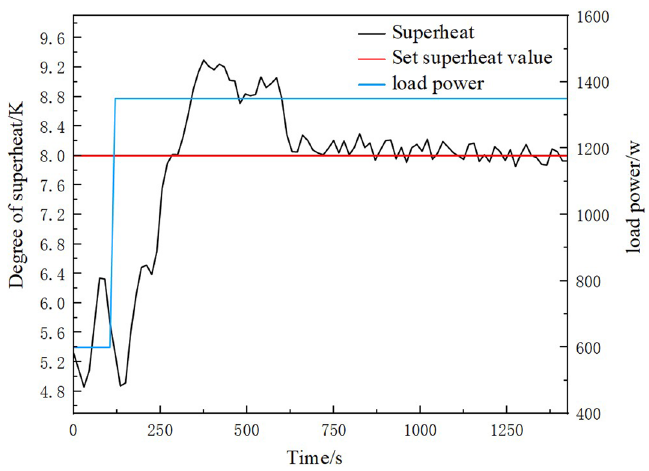
Figure 16. The superheat change process in the 750 W load step